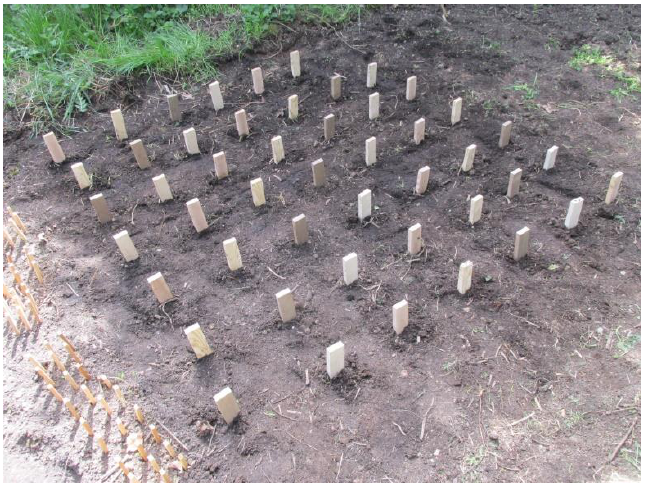
Figure 1. Stakes placed in soil in April 2016.